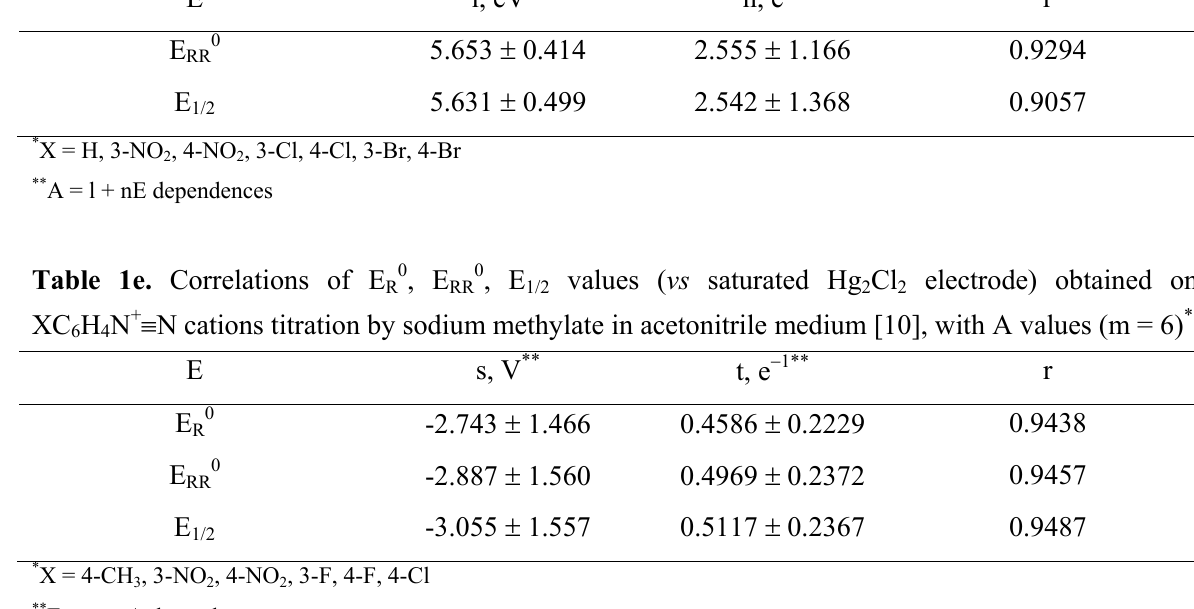
Cl electrode) 2 2